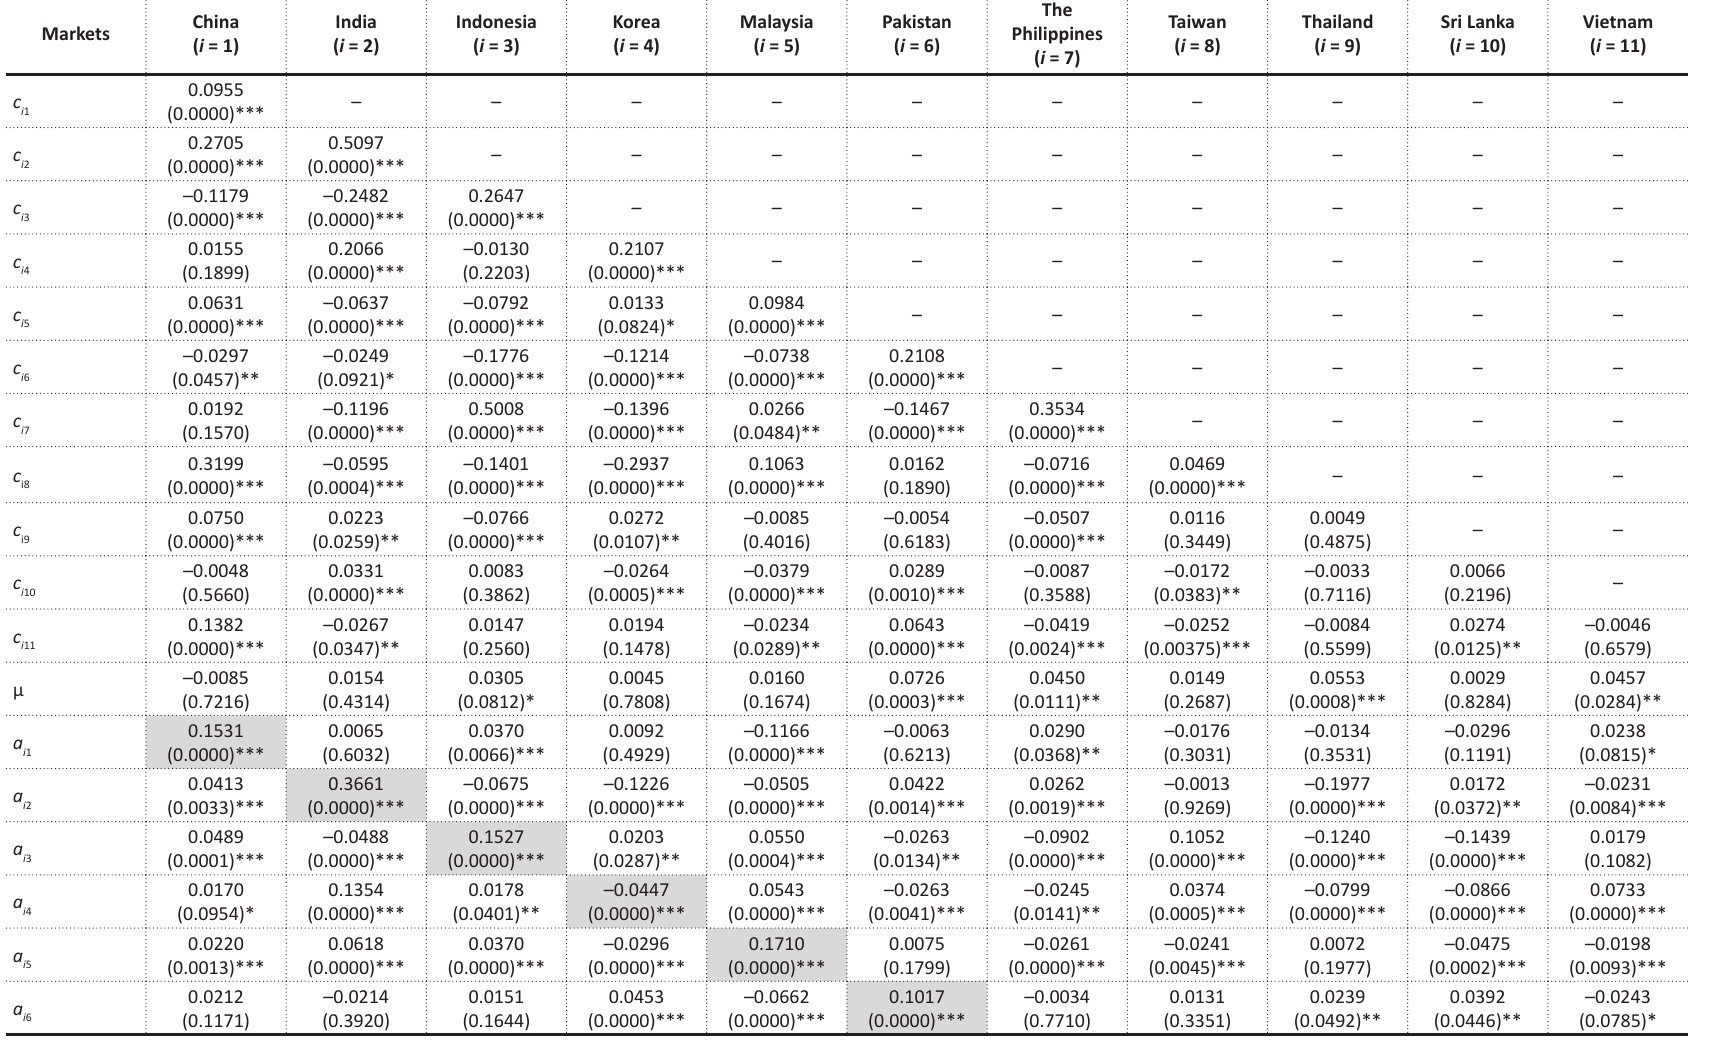
Table 6. Shocks and volatility spillover between stock markets during post-global financial crisis